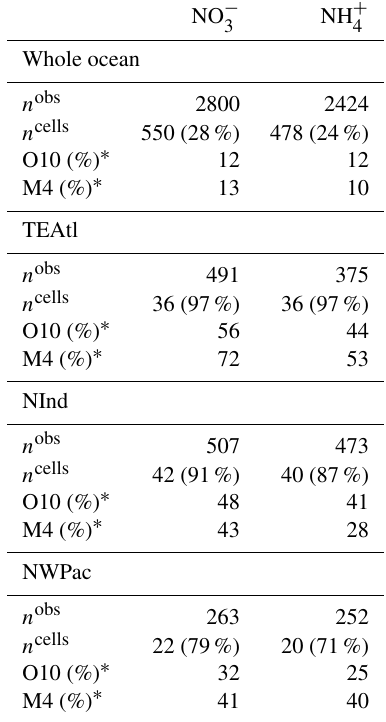
Table 1. Description of the observational databases for NO − NH + for the whole ocean, TEAtl, NInd and NWPac regions. Num- 4 ber of observations ( n obs ) , number (and percentage) of oceanic grid cells containing observations ( n cells ) , percentage of ocean cells con- taining ≥ 10 observations (O10), and percentage of ocean grid cells with observations in ≥ 4 months (M4) are given for each region.